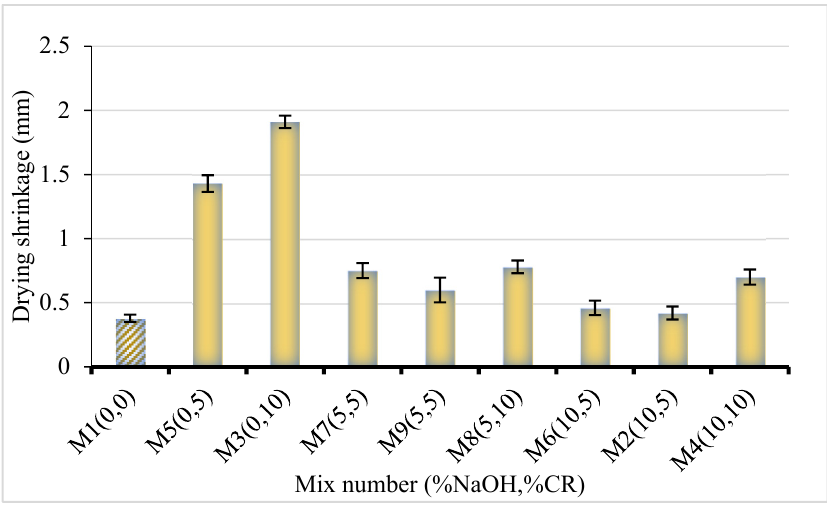
Figure 10. Shrinkage of NaOH-CRC.